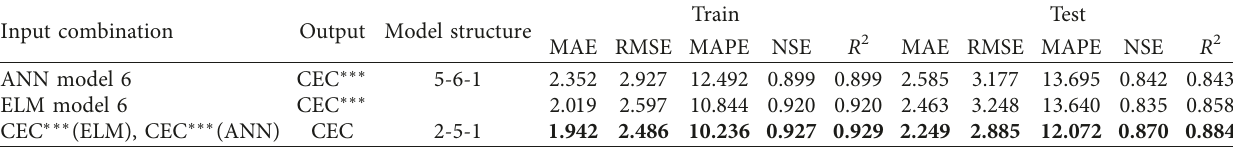
Table 8: Comparing performances of the best models of ANN, ELM, and MM-GANN.